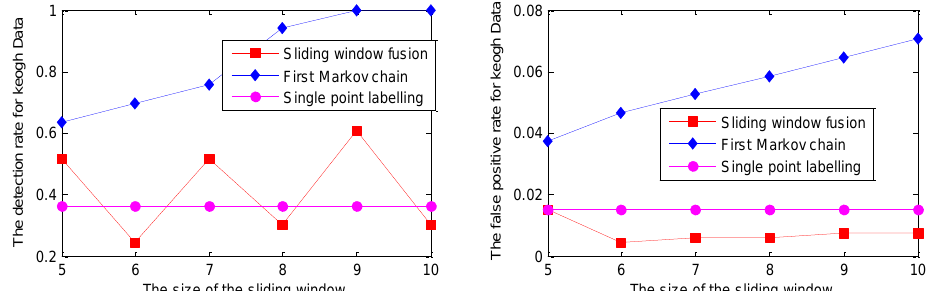
Figure 6. The detection results with the GPR model fused with different labelling strategies under different sizes of the sliding window.